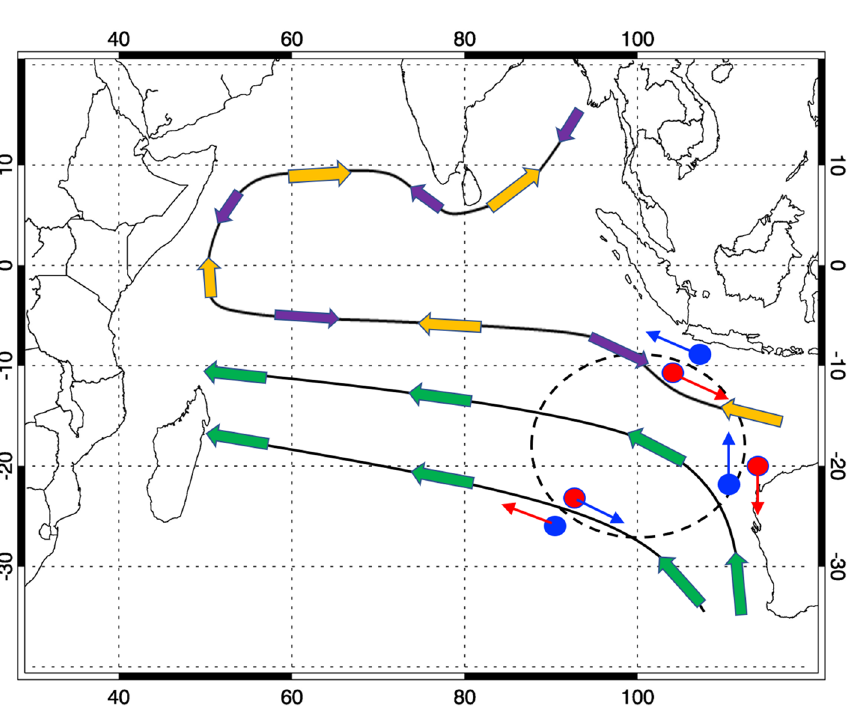
Figure 5. Schematic configuration of the interaction between the Indian Ocean mean state and the ENSO remote forcing. The Indian Ocean mean state is illustrated by the thick arrows, where the thick yellow (purple) arrow represents the boreal summer (winter) monsoonal circulation and the thick green arrow represents the southern Indian Ocean trade wind. El Niño/La Niña remote forcing is illustrated by the anti-cyclonic/cyclonic wind anomalies (thin blue/red arrow) over the dash-line circle region. The positive/negative SST anomaly results from the mean state-perturbation interaction is shown in red/blue dot, respectively corresponding to IODM, Ningaloo Niño/Niña and